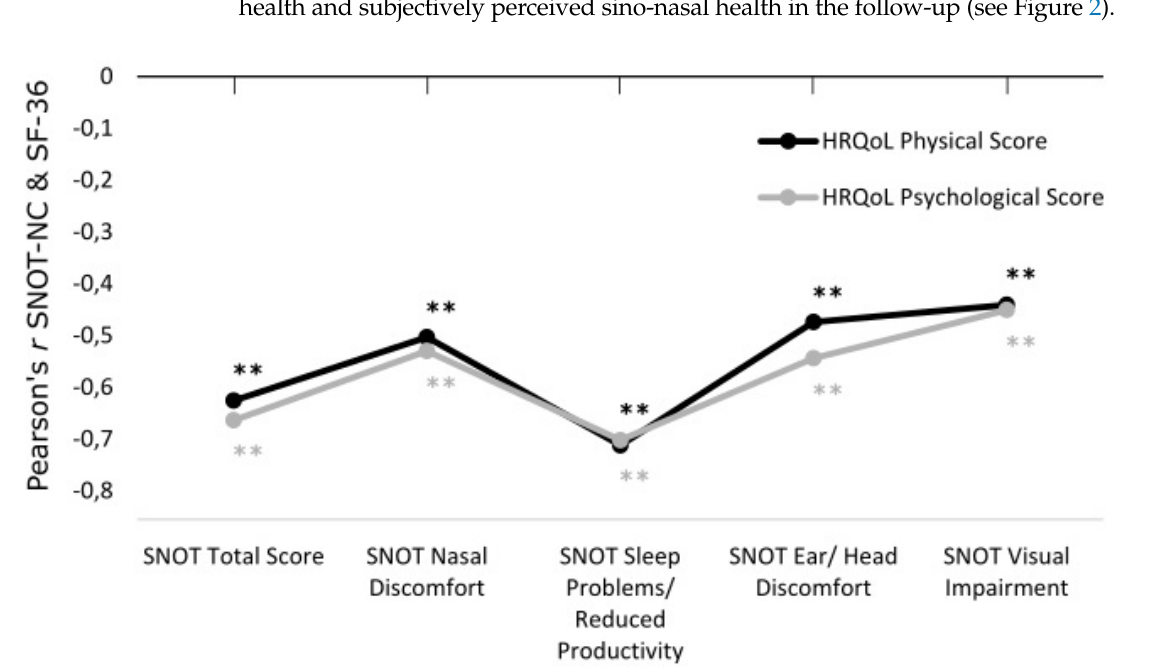
Figure 2. Pearsons’ r correlation coefficients for SNOT-NC Scores and SF-36 Psychological (black) and Physical HRQoL (grey). Double Asterisks ** mark highly significant correlations.